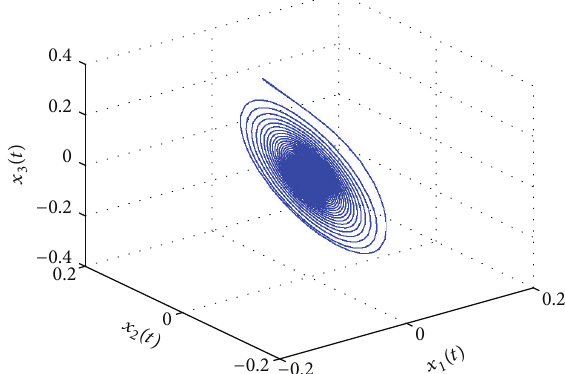
Figure 16: The phase plot of 𝑥 1 , 𝑥 2 , and 𝑥 3 when 𝜏 2 = 1.85 > 𝜏 ∗ = 0.35 1.7488 = 𝜏 ∗ 2 and 1